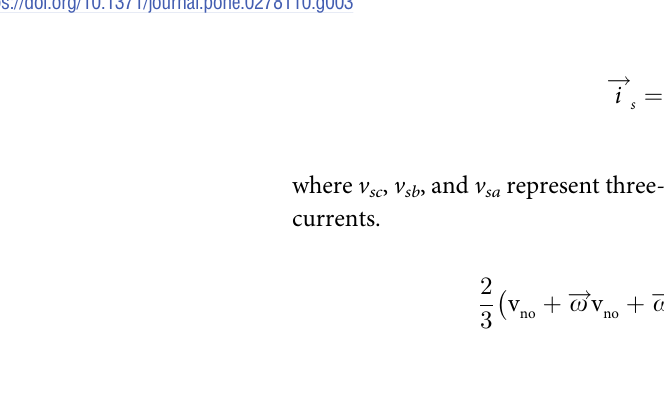
, v , and v represent three-phase voltages and i sc sb sa